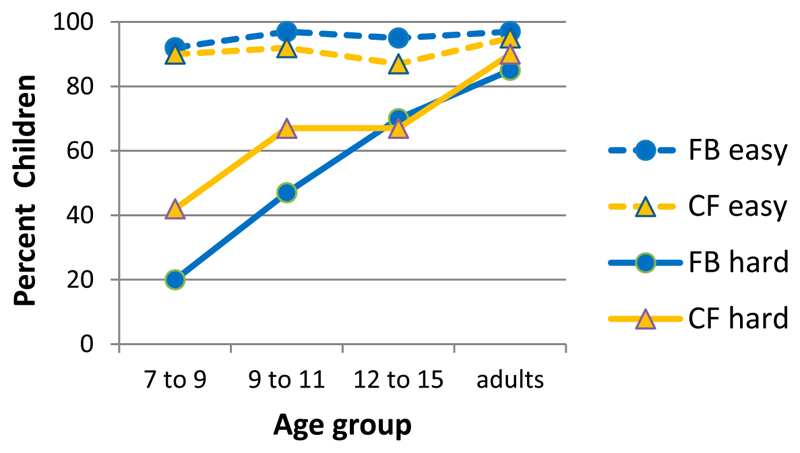
Per cent children who give the correct answer to counterfactual and corresponding false belief questions. Data from Leahy, Rafetseder, and Perner (2017).